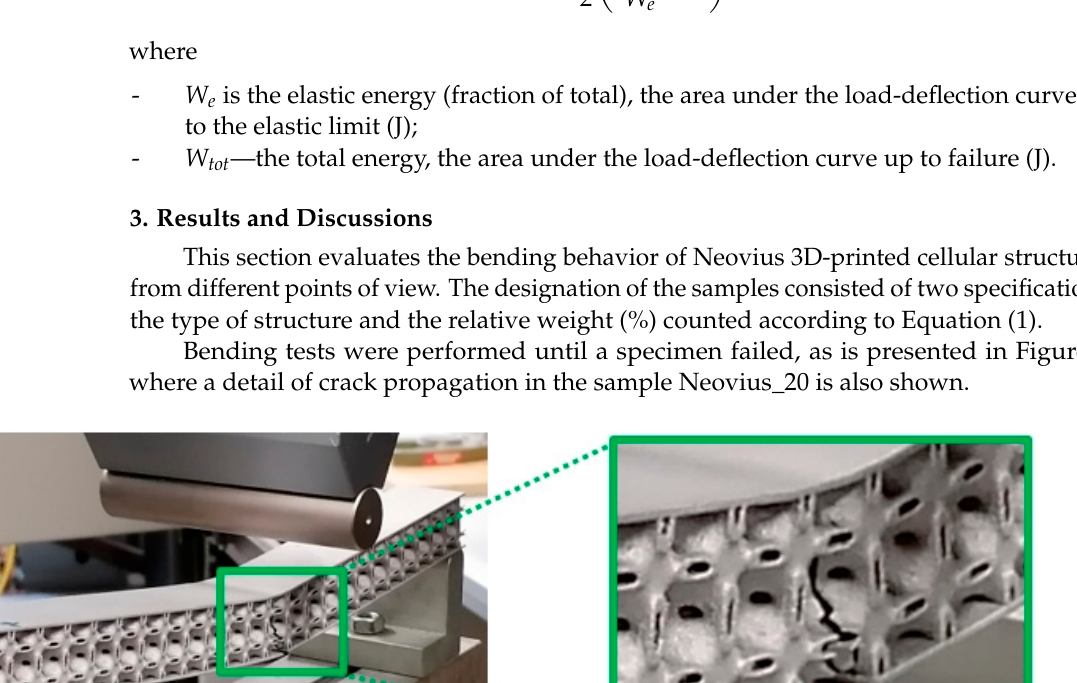
Figure 10. Load-de fl ection curves for 5 di ff erent relative weights of the Neovius structure. Based on the dependencies, subsequently, maximum stresses were computed, and trend curves were generated in the MS Excel software application, which mathematically described the experimentally obtained curves very accurately (with the minimum coe ffi - cient of determination, R 2 = 0.998). By integrating the obtained polynomial functions, the amount of energy needed up to a failure of the sample was calculated for each sample. The values with standard deviations of the maximum stresses and energy absorptions for the samples characterized by individual relative weights are presented via the diagram in Figure 11.